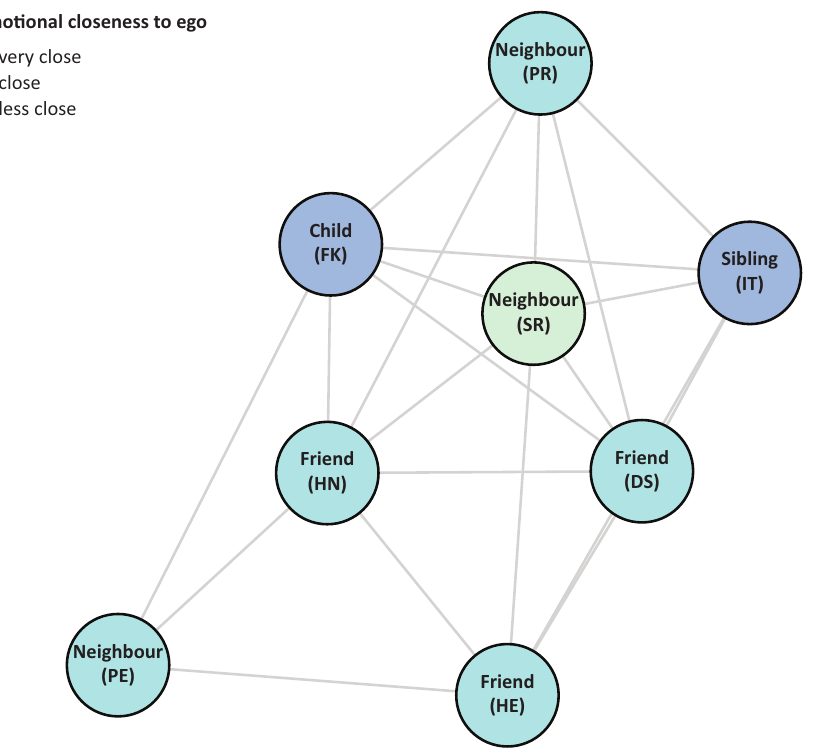
Figure 2. Ego‐centred network of Mrs Schmidt. Notes: Alters’ labels are derived from the relationship type reported by ego and a two‐letter anonymisation key; emotional closeness to ego is indicated by node colour; ties between alters indicate that they “know each other” according to ego’s account; layout based on the Fruchterman‐Reingold algorithm. Own